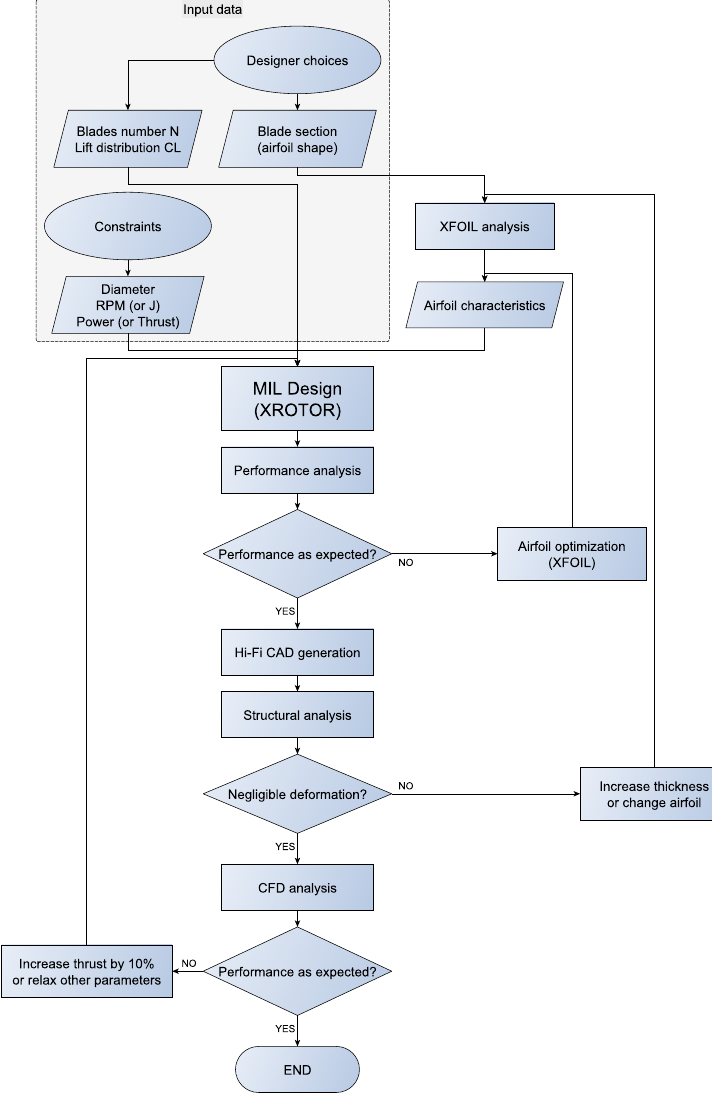
Figure 2. Propeller design